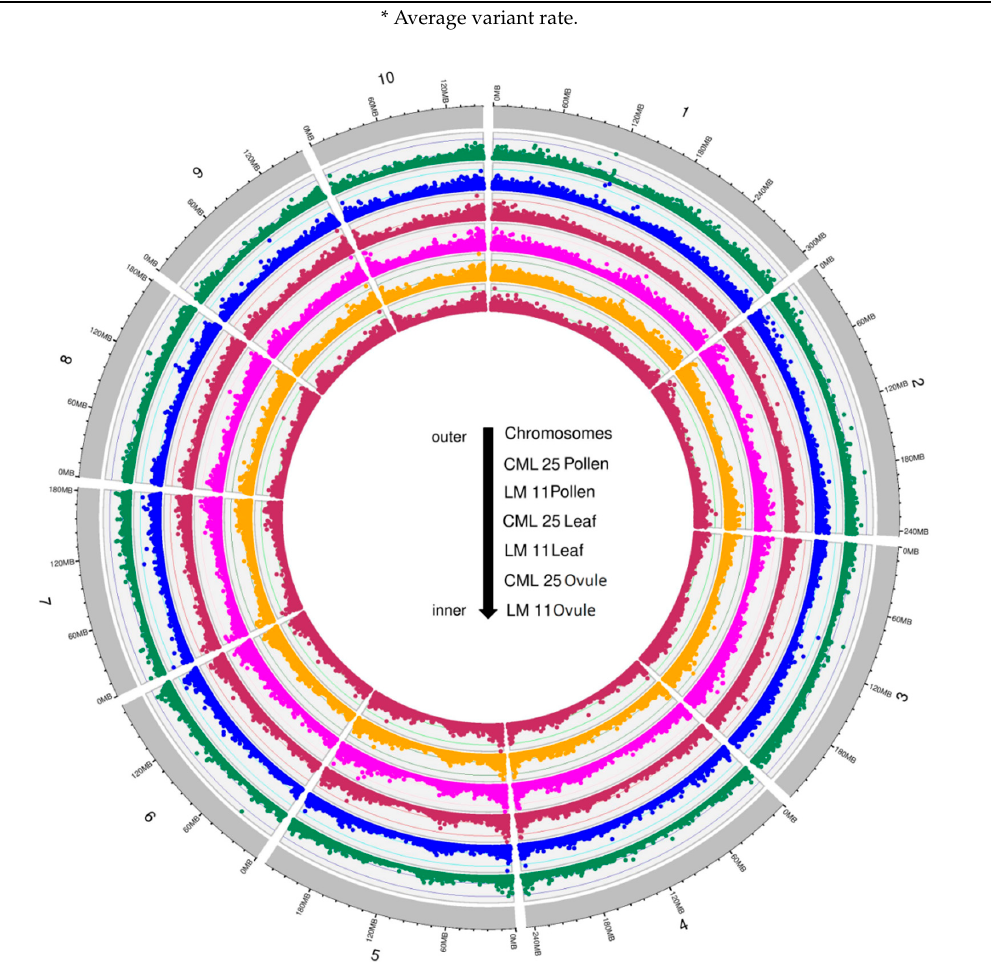
Figure 2. Density distributions of variants in pollen, leaf, and ovule from the CML25 and LM11 in all the 10 chromosomes of maize.